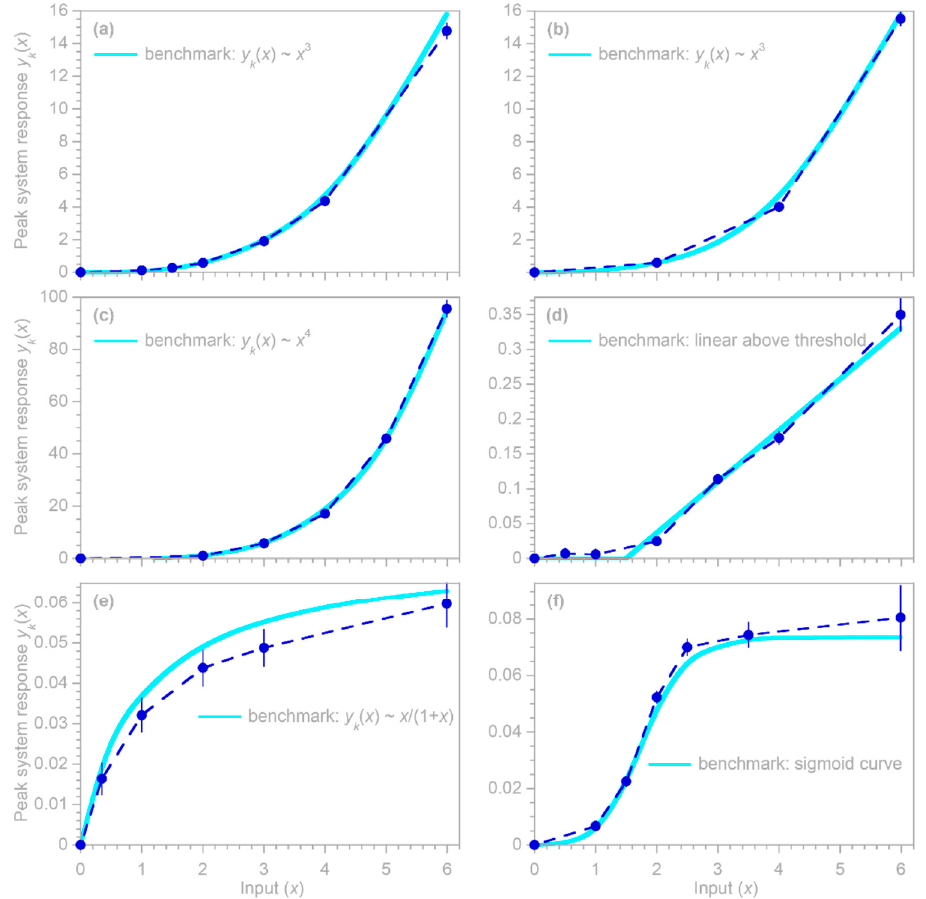
Figure 11. Benchmarks (light blue lines) and estimated peak system responses (dark blue dots) for benchmark tests featuring a range of nonlinear relationships between the peak system response y k ( x ) and the input x . In both ( a , b ), the benchmark’s peak response varies as the cube of the input, but knots divide the input values into six intervals in ( a ) and only three intervals in ( b ). The other relationships include a quartic curve ( c ), a linear function above a threshold ( d ), the Michaelis–Menten saturation curve ( e ), and a sigmoid curve ( f ). Except for some systematic bias in ( e ), the estimates derived from the approach outlined in Section 5.1 (blue circles) closely approximate the benchmark curves, with deviations similar to the estimated standard errors (as shown by the error bars, where these are larger than the plotting symbols).